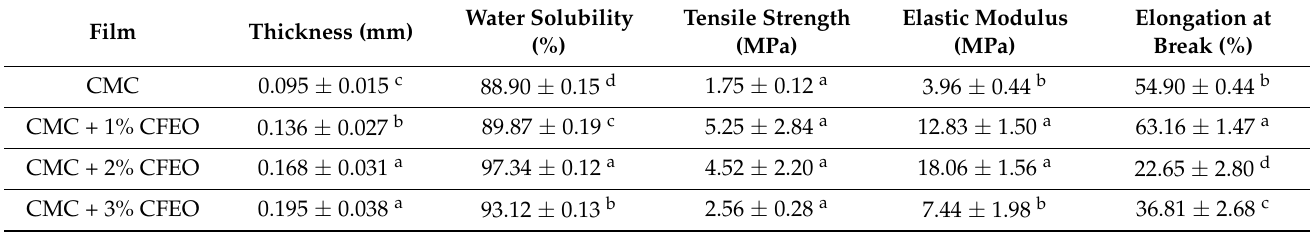
Table 2. Mechanical and physical properties of CMC and blended CMC-CFEO films.